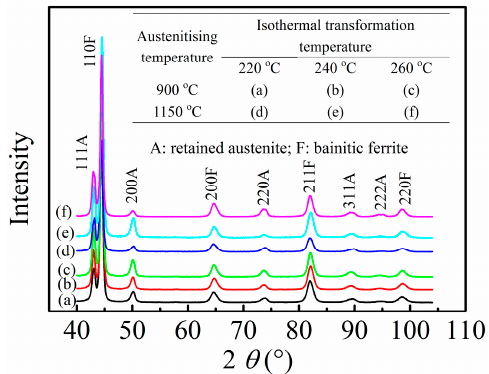
Figure 4. XRD patterns of samples isothermally transformed at 220 °C, 240 °C, and 260 °C after austenitised at ( a – c ) 900 °C; and ( d – f ) 1150 °C.